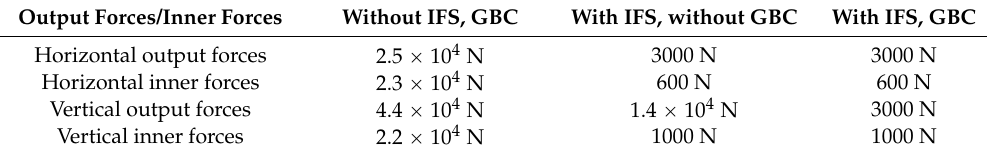
Table 3. The maximum inner forces and output forces with different controllers under random signals.